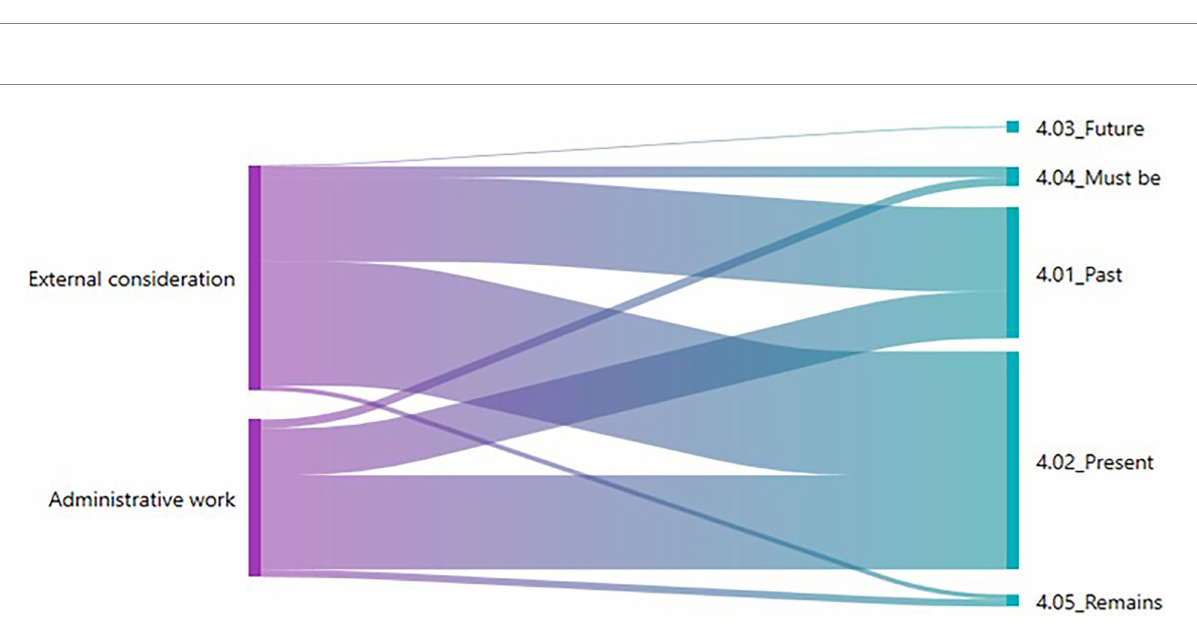
FIGURE 5 Sankey diagram of concurrence between central categories and